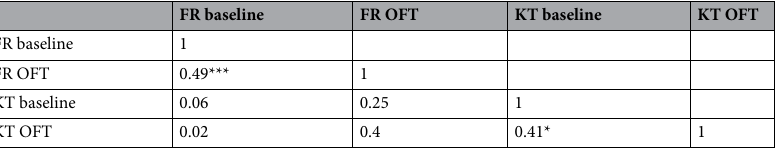
Table 3. Correlations between the FRT and KT for the absolute LI. Numbers indicate correlation coefficients. Asterisks indicate p-values with *p < 0.05, ***p < 0.001.